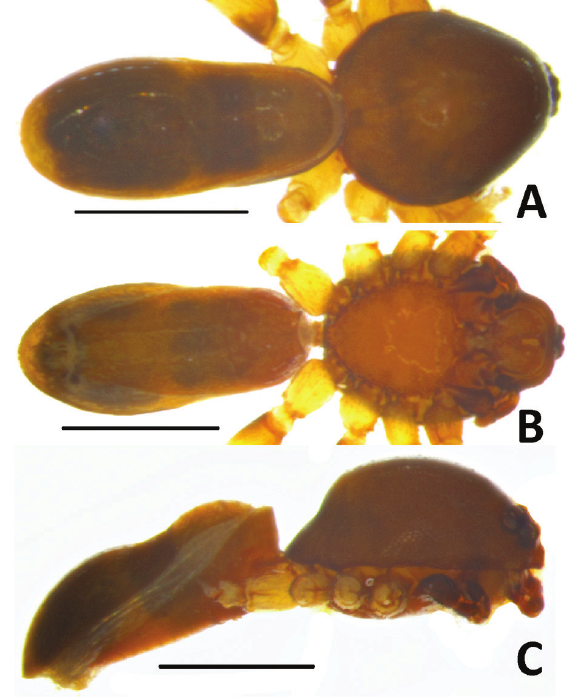
Figure 6. Ischnothyreus chippy n. sp., male from a forest be- tween Koslanda and Beragala: A , habitus, dorsal view; B , same, ventral view; C , same, lateral view. Scale bars: 0.5 mm.